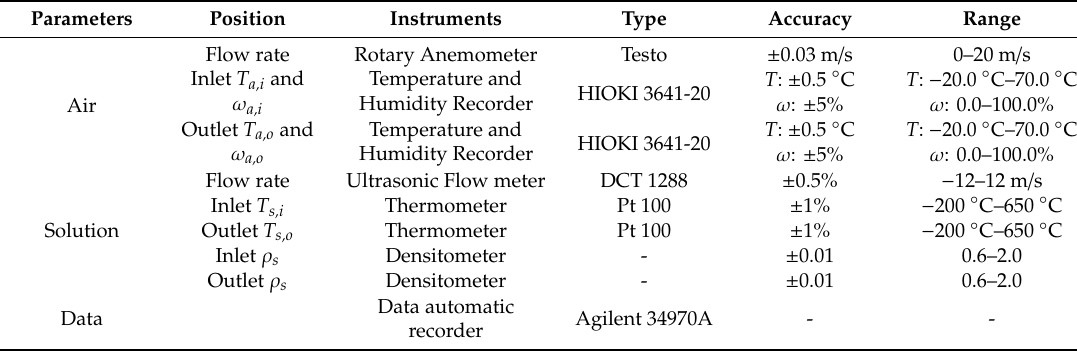
Figure 6. Schematic diagram of the experimental device setup. Table 3. Experimental parameters and instruments.